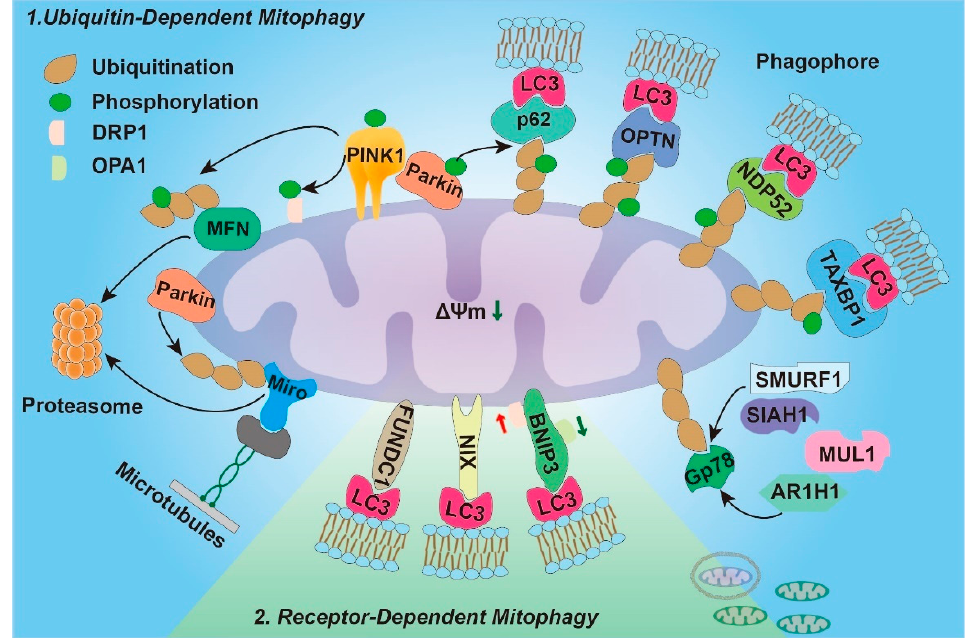
Figure 1. Molecular mechanism of mitophagy. In the PINK1–Parkin pathway, decreased MMP leads to the accumulation of PINK1 to the OMM, promoting Parkin recruitment. Parkin ubiquitinates several outer membrane components, and PINK1 then phosphorylates the poly-Ub chains. The poly-Ub chains on the OMM allow the interaction of mitochondria with LC3 for autophagic degradation through specific adaptors, such as p62, OPTN, TAX1BP1, and NDP52. Gp78, SMURF1, MUL1, SIAH1 and ARIH1 represent alternative E3 ubiquitin ligases targeting OMM proteins before mitophagy. Mitochondrial dynamics and motility are modulated by the PINK1–Parkin pathway by targeting MFN, DRP1 and Miro for degradation by proteasomes. In receptor-mediated mitophagy, BNIP3, NIX and FUNDC1 mitophagy receptors mediate mitochondrial elimination indirectly by interacting with LC3.